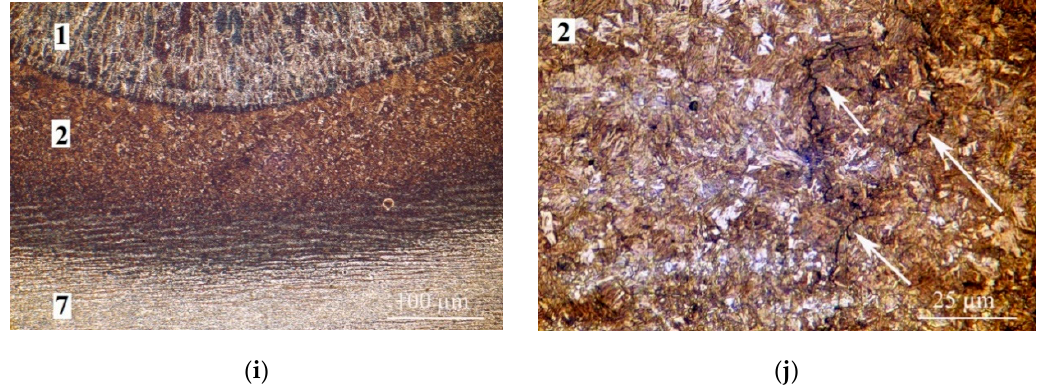
Figure 6. Results of TBW microscopic testing; 1—first bead, 2—HAZ under first bead, 3—area of the HAZ of the second bead overlapping the first bead, 4—HAZ of the second bead overlapping the HAZ of the first bead, 5—second bead, 6—HAZ under the second bead, 7—base metal. ( a , b ) pitch 11%; ( c , d ) pitch 43%; ( e , f ) pitch 55%; ( g , h ) pitch 73%; ( i , j ) pitch 100%. Etch. Nital 4%.